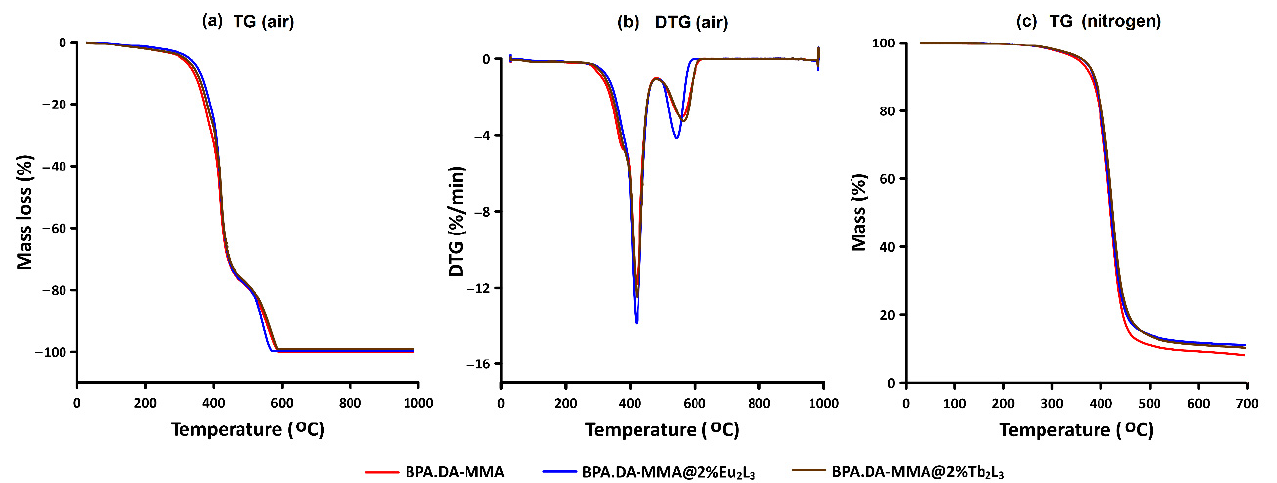
Figure 4. ( a ) TG and ( b ) DTG curves of the BPA.DA-MMA matrix, BPA.DA-MMA@2%Eu 2 L 3 , and BPA.DA-MMA@2%Tb 2 L 3 materials (block form) in air atmosphere. ( c ) TG curves of materials (block form) in nitrogen